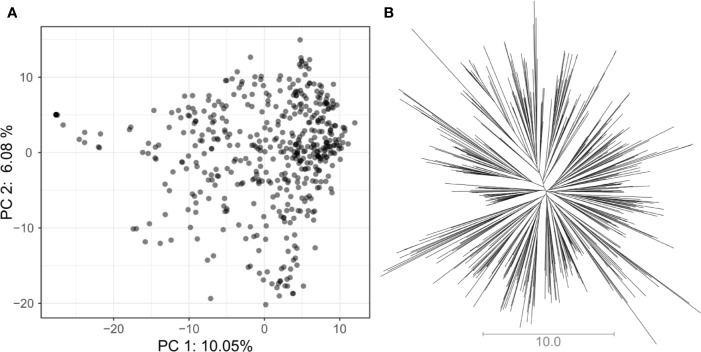
Assessment of population structure for the VEF population including 481 common bean lines with 5,820 SNP markers: (A) The principal component analysis shows the location of each genotype defined by the eigenvectors of the first and second principal components. (B) The unrooted neighbor-joining tree indicates the absence of a clear differentiation pattern between lines. The length of the lines in the tree shows the simple matching distance.